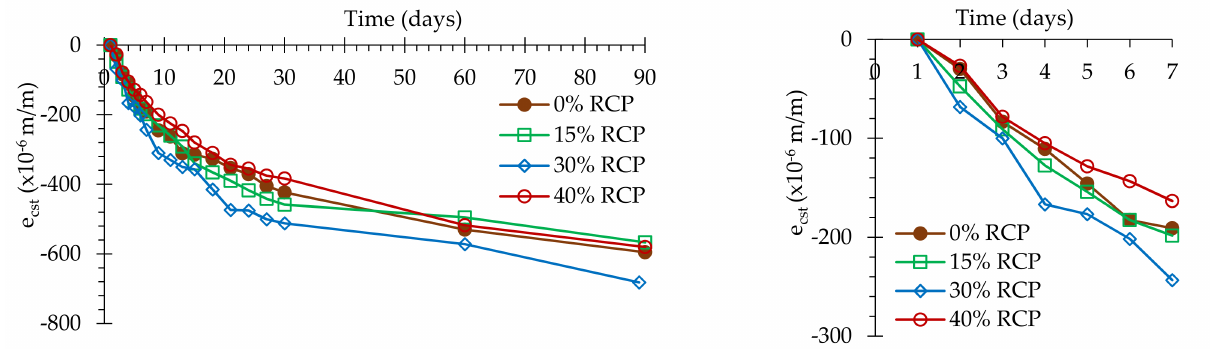
Figure 23. Drying shrinkage, e cst , of concrete with a w/b of 0.55 and different incorporation percentages of RCP up to 90 days ( left ) and up to 7 days ( right